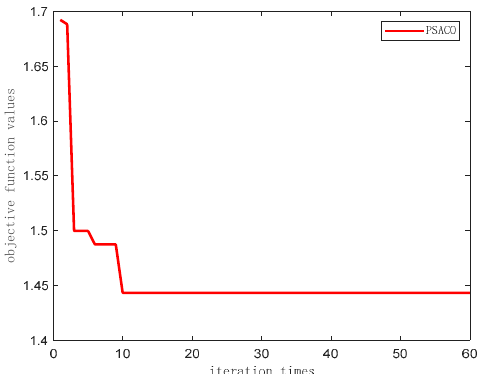
Figure 9. Iterative process diagrams of PSACO.